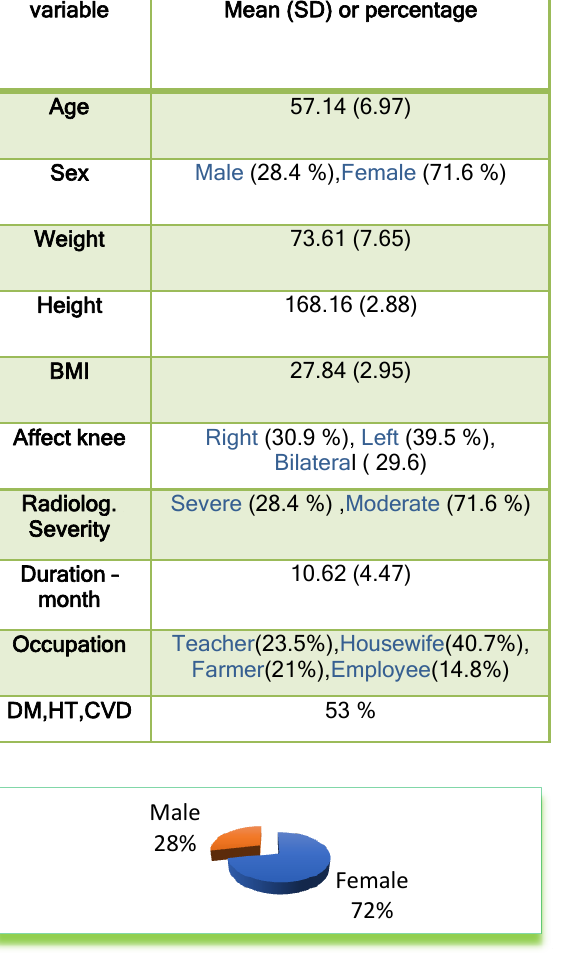
Figure 7: The patients demographic data.